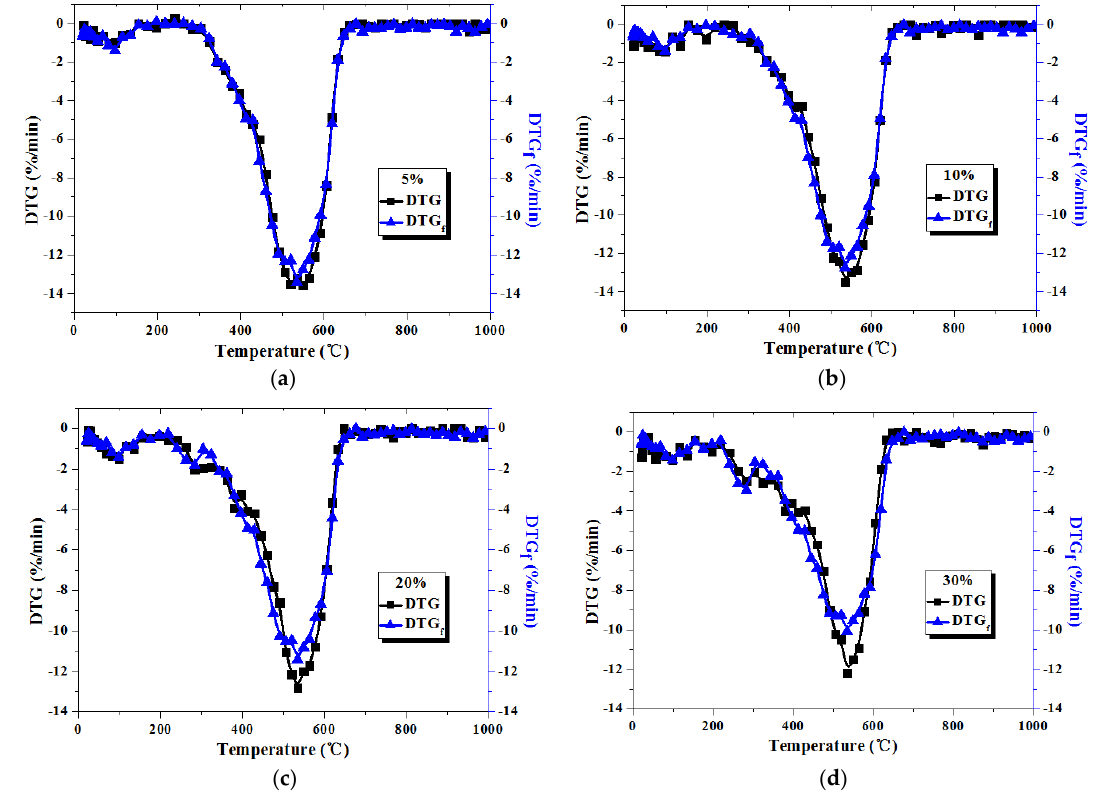
Figure 2. Actual and fitted DTG curves for coal-sludge (S 1 ) blends of different dried sludge weight percentages (heating rate = 30 °C/min) (( a ) 5%; ( b ) 10%; ( c ) 20%; ( d ) 30%). Table 3. Comparison of the maximum weight loss rate of the fitted and actual curves with different heating